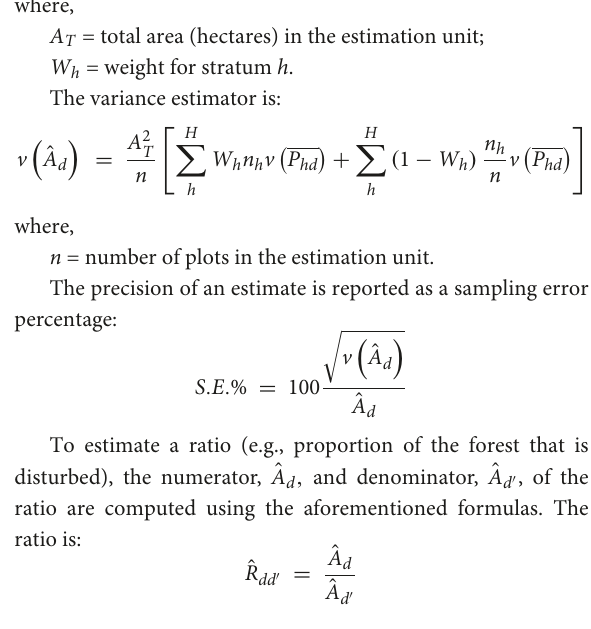
TABLE 5 Annual disturbance (1000 hectares) by agent